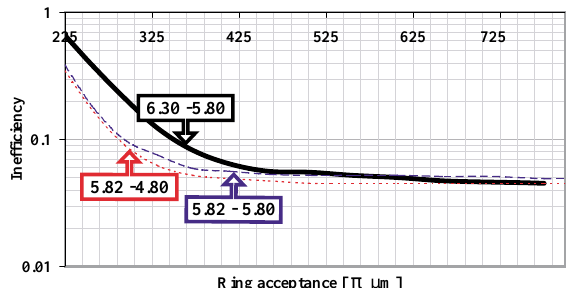
FIG. 11. (Color) Residual halo profile for three different work- ing points. The nominal tune is presented on the top curve (anticorrelated painting